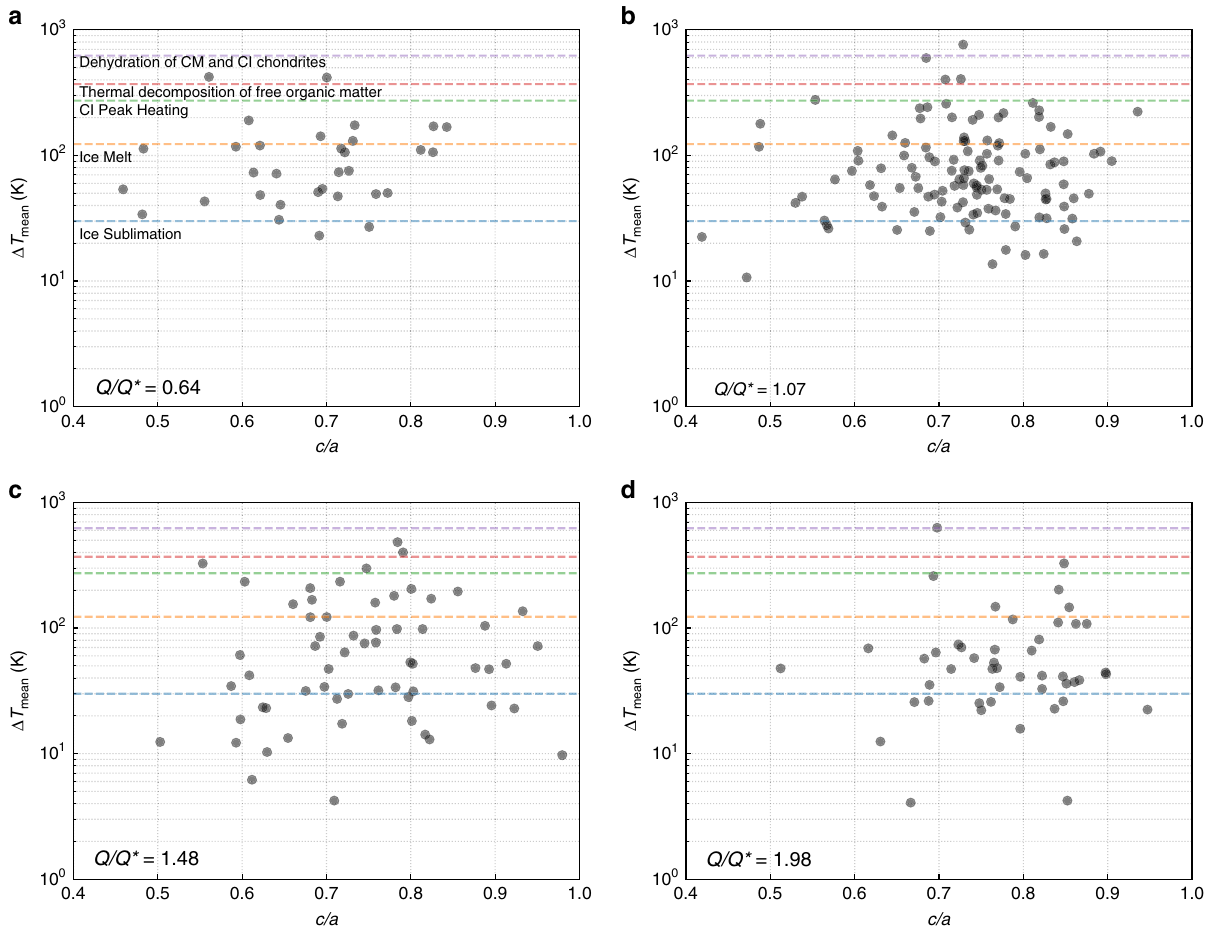
Fig. 6 A catastrophic impact thermally alters material that forms rubble-pile asteroids. From a to d , the impact energy Q is increased from below the impact energy threshold for disruption Q* ( a ) to above Q* ( b – d ). For every reaccumulated aggregate in a simulation, we calculate the mean change in temperature by averaging the peak temperature changes of each component particle. We plot this value as a function of the minor-to-major axis ratio ( c / a ), which tracks the sphericity of each represented object. We fi nd that the aggregates are able to experience mean temperature changes that likely altered the material from its original state within the parent body. The degree of alteration is independent of the fi nal asteroid shapes, and different spheroidal or top-shaped asteroids can have varying degrees of thermal alteration driven by impact-induced heating (as shown for the two aggregates in Fig. 2). Unintuitively, rubble piles generated from less energetic impacts are more likely to be thermally altered, and super-catastrophic impacts produce a more diverse population of objects. Assuming an initial isothermal target with a temperature of 150 K 59 , we highlight the change in temperature thresholds for ice sublimation (180K, blue dashed line), ice melt (273 K, orange dashed line), CI peak heating (423 K, green dashed line 60 ), the thermal decomposition of free organic matter (520 K, red dashed line 61 ), and the dehydration of CM and CI chondrites (773 K, purple line 36